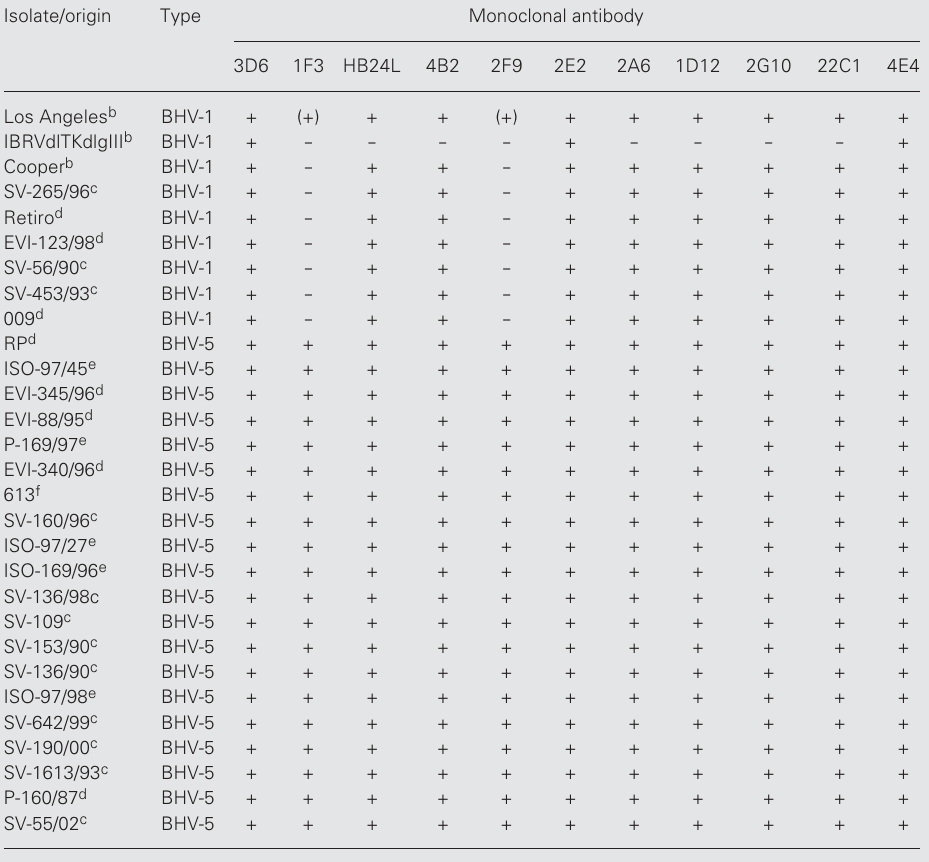
Table 2. Reactivity of monoclonal antibodies produced against antigens of a Brazilian bovine herpesvirus type 5 (BHV-5) isolate, with BHV-5 and BHV-1 field isolates and laboratory reference strains a .